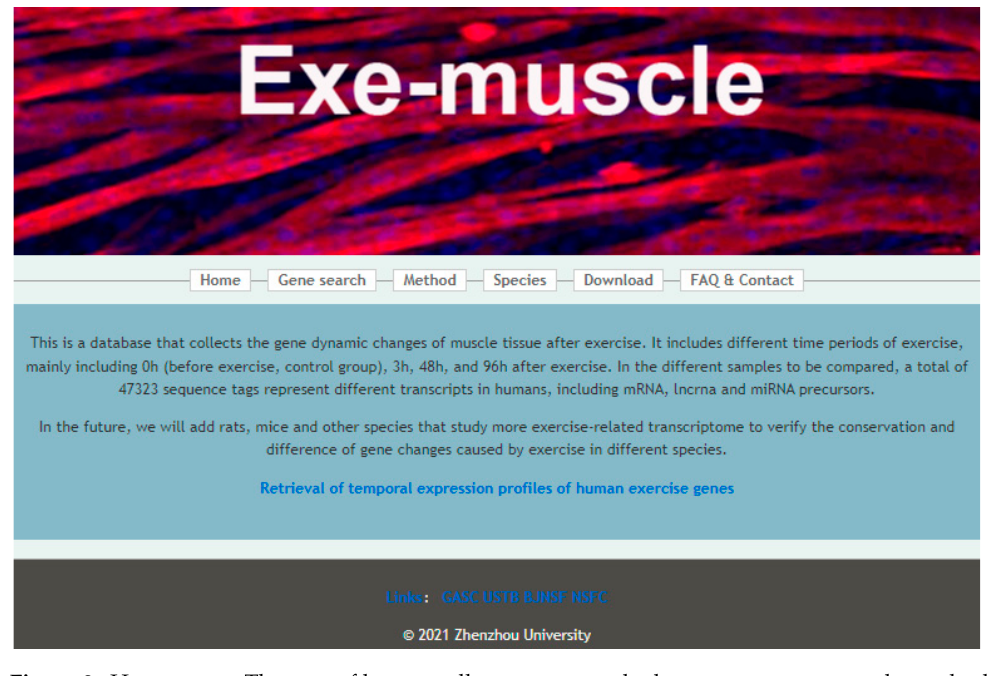
Figure 2. Home page. The row of buttons allows access to the home page, gene search, method, species, download, FAQ, and contact pages. Below is a simple description of Exe-muscle.